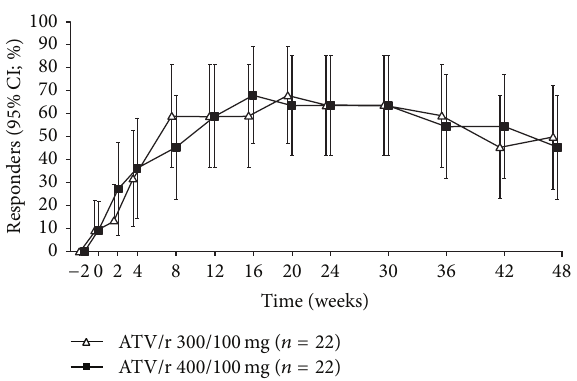
Figure 5: Virologic response (viral load (VL) < 50 copies/mL) over time to Week 48 (intent-to-treat noncompleter equals failure: NC = F). NC = F missing values after discontinuation imputed with change = 0. Last observation was carried forward otherwise. ATV/r: atazanavir/ritonavir; CI: confidence interval; VL: viral